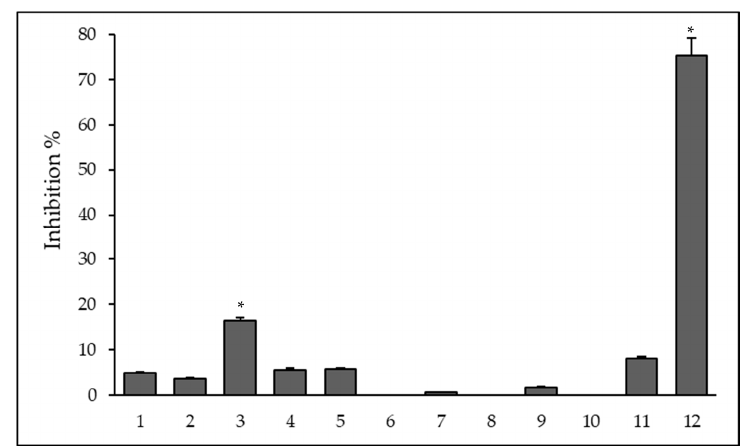
Figure 1. Anti-biofilm effect of ligands and their metal complexes on Staphylococcus aureus ATCC 25923 at ¼ MIC. The level of significance was * p < 0.001. Table 4. The quorum sensing inhibitory e ff ect of the active compounds and the positive control promethazine (PMZ).